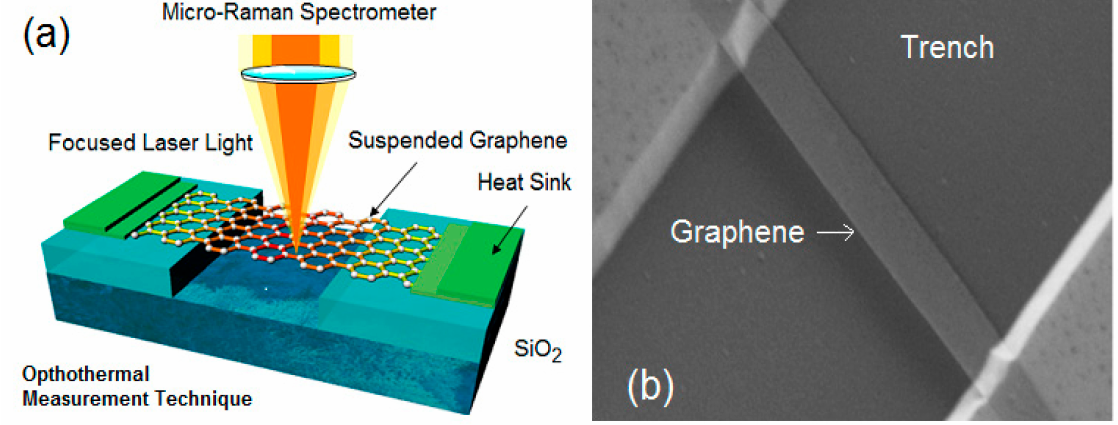
Figure 1. ( a ) Schematic of the suspended graphene structure used for measurements of the thermal conductivity of graphene. Graphene was heated with the laser light focused in the middle of the suspended part. The temperature rise was determined from the shift of the G peak position in graphene Raman spectrum; ( b ) Scanning electron image of the bilayer graphene ribbon suspended across the 3-μm trench in Si/SiO 2 wafer for optothermal measurements. The image is reproduced with permission from [1]. Copyright 2010 Nature Publishing